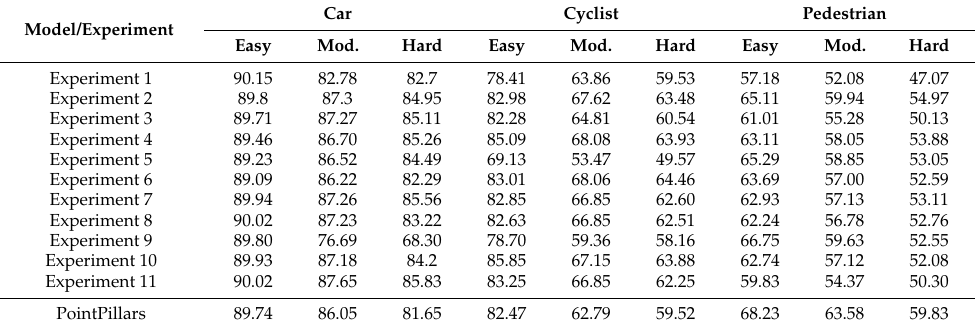
Table 7. Results in validation set for BEV detection metric.